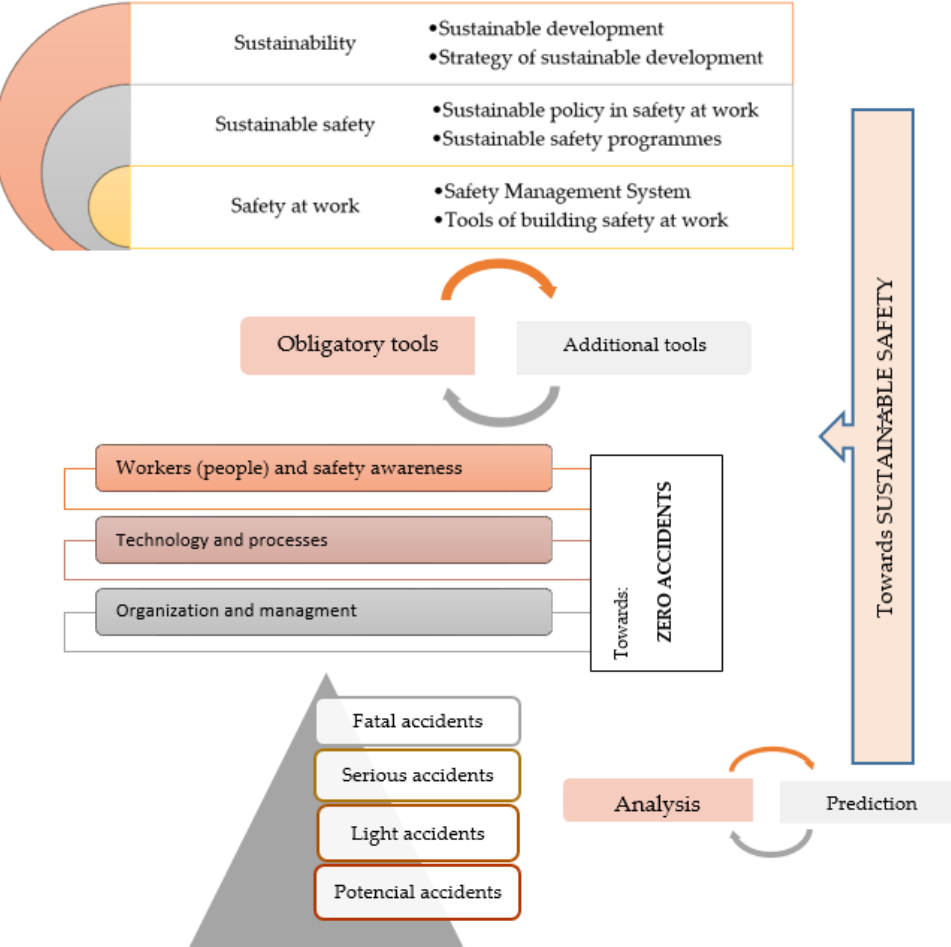
Figure 8. Place of work accidents analysis in sustainable safety in an enterprise.